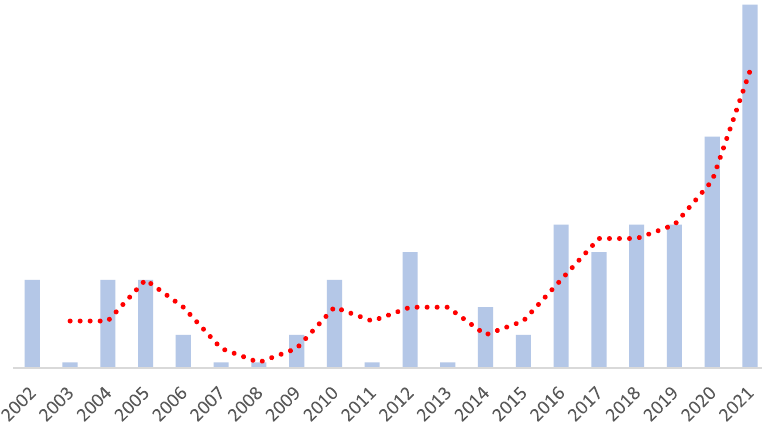
Figure 4. Relative frequency of total disputes arose in NSW. The blue columns represent the relative frequencies and the dotted red line shows the trend.